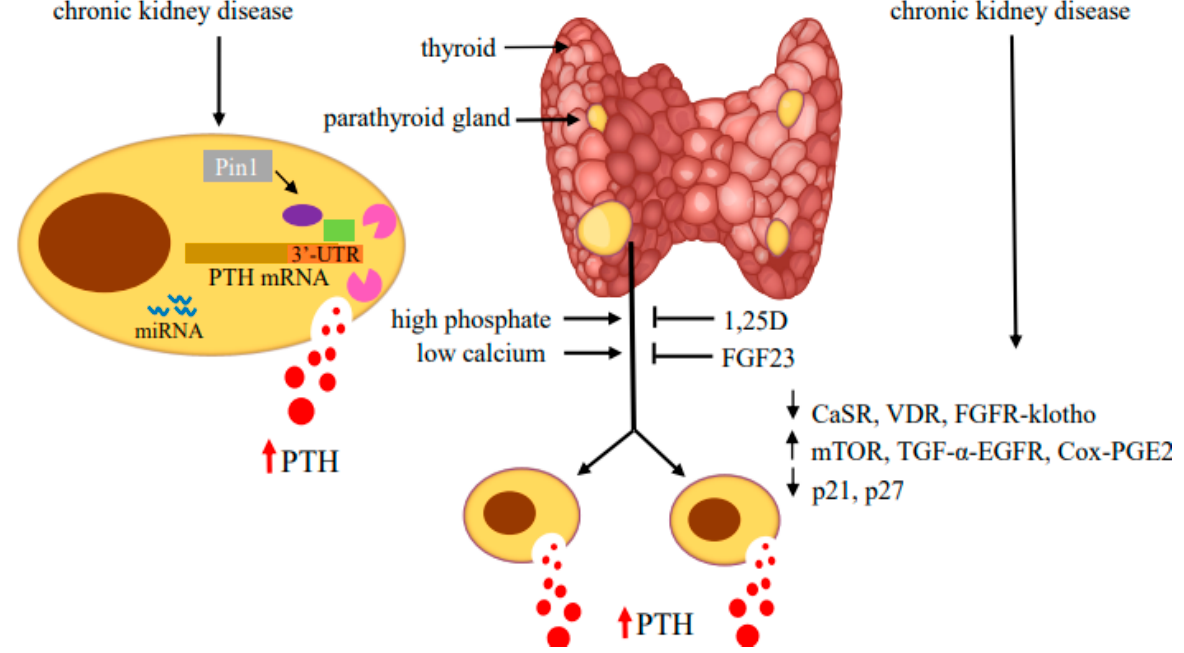
Figure 3. Regulators of PTH gene expression and parathyroid cell proliferation in SHP. Hyperphosphatemia and hypocalcemia stimulate and 1,25(OH) 2 vitamin D (1,25D) and fibroblast growth factor (FGF) 23 inhibit PTH production and parathyroid cell proliferation. In CKD ‐ induced SHP, decreased expression of the CaSR, VDR and FGFR ‐ klotho receptors together with activation of mTOR, TGF ‐α‐ EGFR and Cox ‐ PGE2 signaling and changes in cell cycle regulators lead to hyperplastic parathyroid glands with high serum PTH levels. In the parathyroid cell, protein–PTH mRNA interactions mediated by activity of the isomerase Pin1 and miRNA increase PTH production and secretion. Adapted with permission from the International Journal of Molecular Sciences [99].